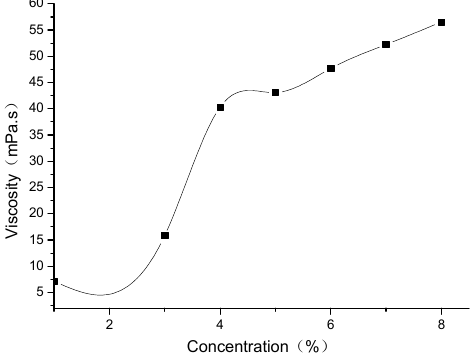
Figure 5. Effect of concentration on the viscosity of DS18-3-18.